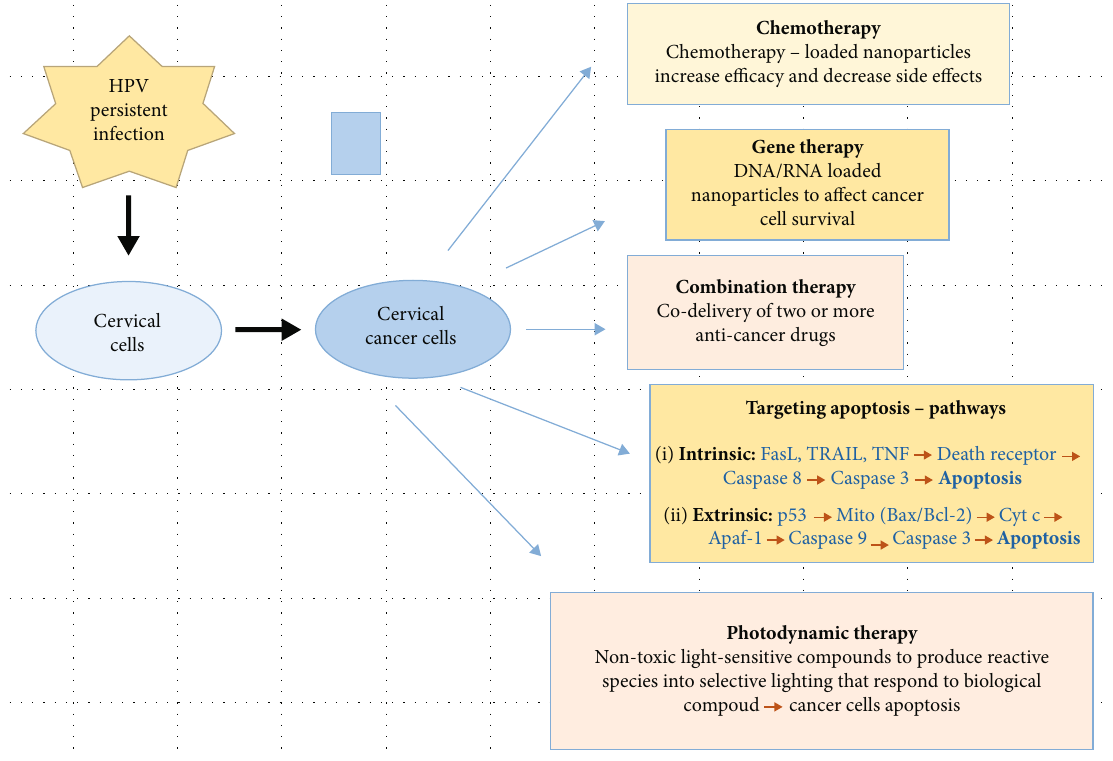
Figure 1: Nanotechnology application in the treatment of cervical cancer (modi fi ed after Chen et al. [17]). HPV: human papilloma virus.